Question: Express in one sentence what the figure is showing.
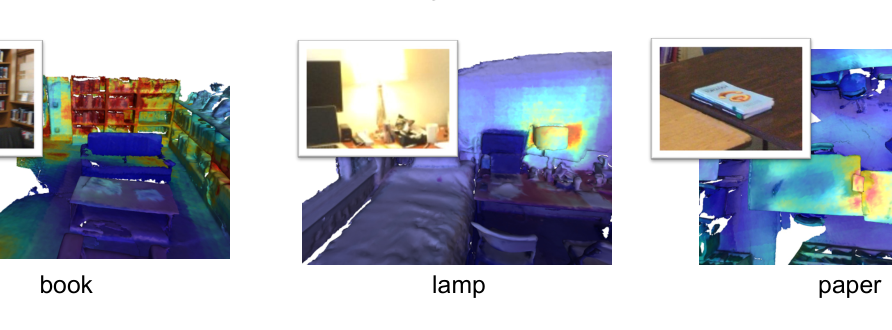
Answer: Visualization in heat map of tail classes with the annotation-free model on ScanNet.